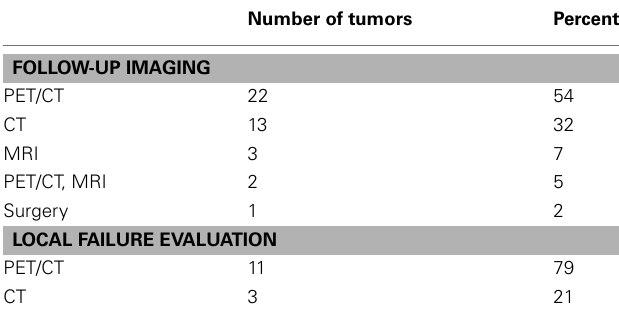
Table 2 | Summary of the follow-up imaging performed denoting the imaging modality used in the assessment of the 14 local